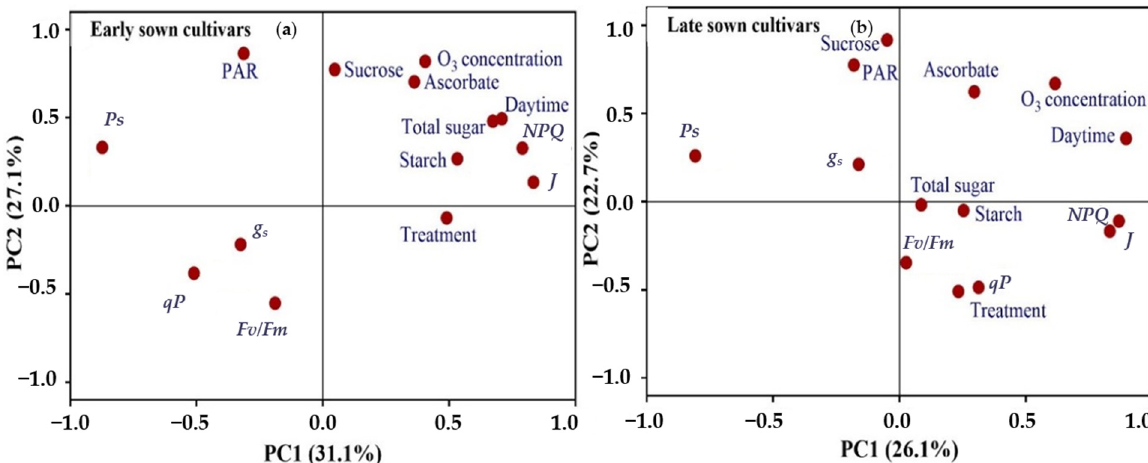
Figure 6. Principal Component Analysis (PCA) biplot for all the diurnally recorded parameters representing two principal